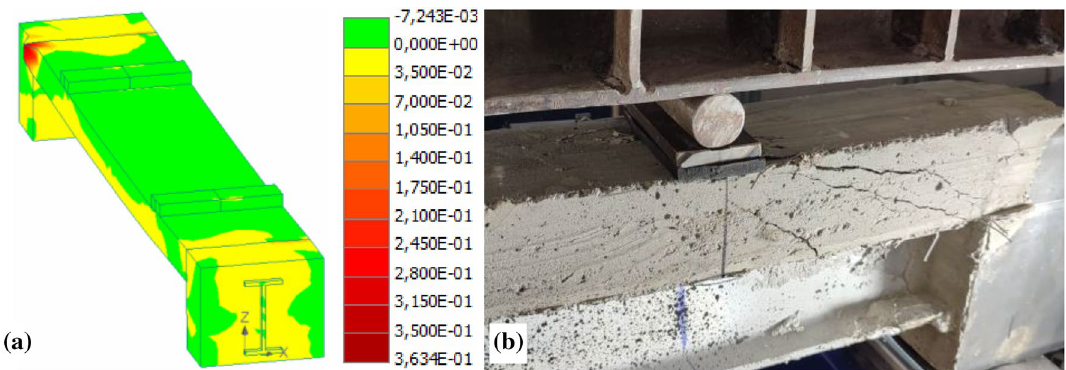
Figure 9. Failure mechanisms of the hybrid beams: ( a ) The predicted strain distribution in the FE model with the perfect bond (Fig. 6a); ( b ) Shear failure of the concrete in the second series